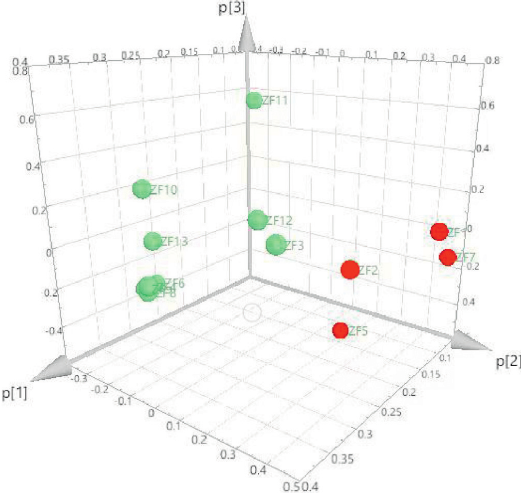
Figure 5: Three-dimensional loading